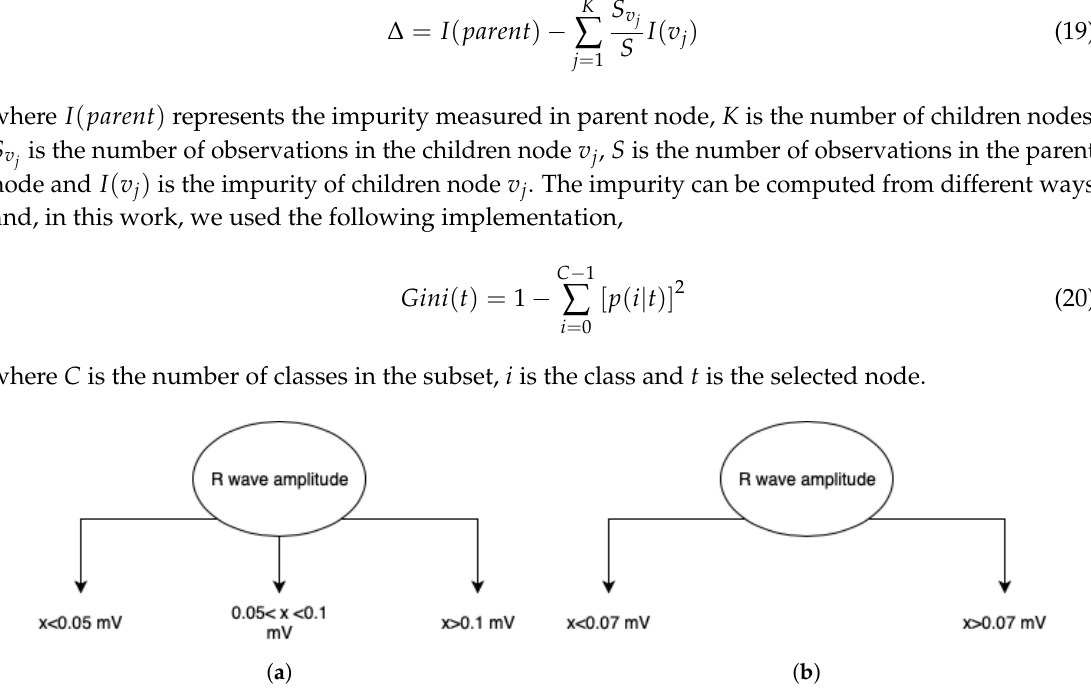
Figure 4. Examples of attribute test condition. ( a ) Non-binary attribute test condition. ( b ) Binary attribute test